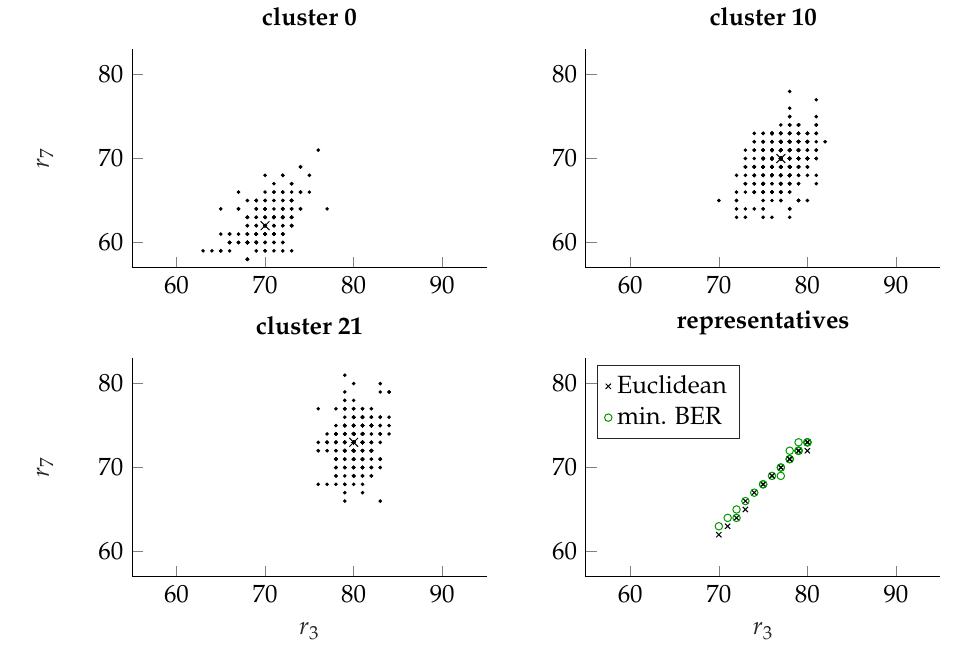
Figure 9. Exemplary clusters for filling the calibration table.